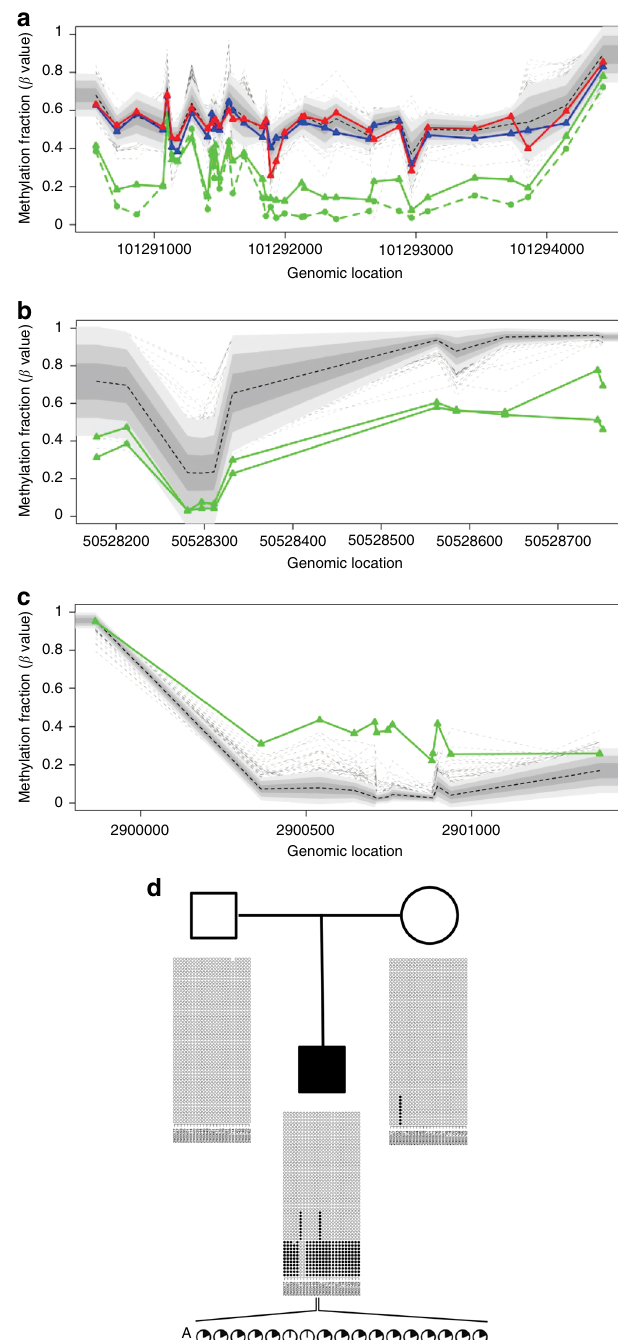
Fig. 1 Large gains and losses of DNA methylation identi fi ed in patients with ND – CA. Plots a , b , and c show β values obtained from Illumina 450k array for probands (highlighted in green) and 1534 controls (shades of gray corresponding to ±1, ±1.5, and ±2 standard deviations from the population mean, represented by the dashed black line; dashed gray lines represent controls with outlier methylation levels). a Recurrent hypomethylation of the imprinted locus of MEG3 (hg19: chr14:101290194 – 101294429) in Proband 398 (solid green line) and Proband 146 (dashed green line). The epivariation in Proband 398 is de novo as both mother (red line) and father (blue line) present methylation pro fi les similar to controls. b Recurrent hypomethylation at the promoter, 5 ’ UTR, and fi rst exon of MOV10L1 (hg19: chr22:50528178 – 50528751) observed in two unrelated probands: Proband 22 (de novo epivariation) and Proband 117 (inheritance unknown). c Hypermethylation of ZNF57 in Proband 381. d Pedigree and graphical representation of the methyl-seq data consistent with allele-speci fi c nature of a de novo hypermethylation identi fi ed in ZNF57 is shown. Each plot shows the methylation pattern for an amplicon, with each row representing a single bisul fi te read and each column one CpG in the amplicon. Black circles are methylated CpGs and white circles unmethylated CpGs. Based on the presence of a heterozygous SNP within the DMR (hg19: chr19:2900643), the observed gain of methylation occurs speci fi cally on one allele: each pie chart shows the methylated fraction of reads per